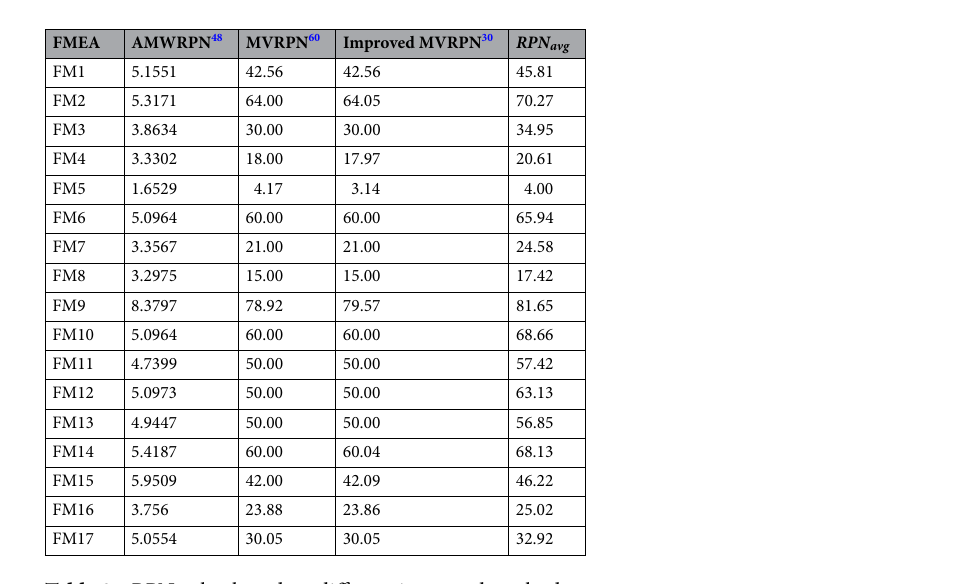
Table 8. RPN value based on different improved